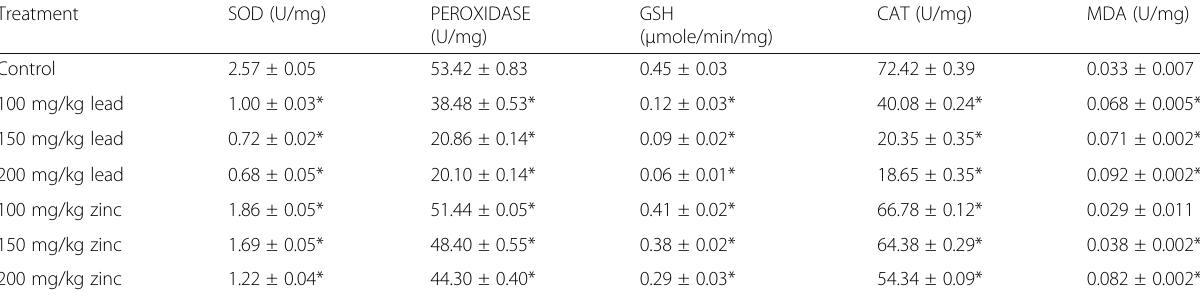
Table 2 Impact of different concentrations of lead and zinc nitrate on some enzymes and lipid peroxidation in Bambara nut Treatment